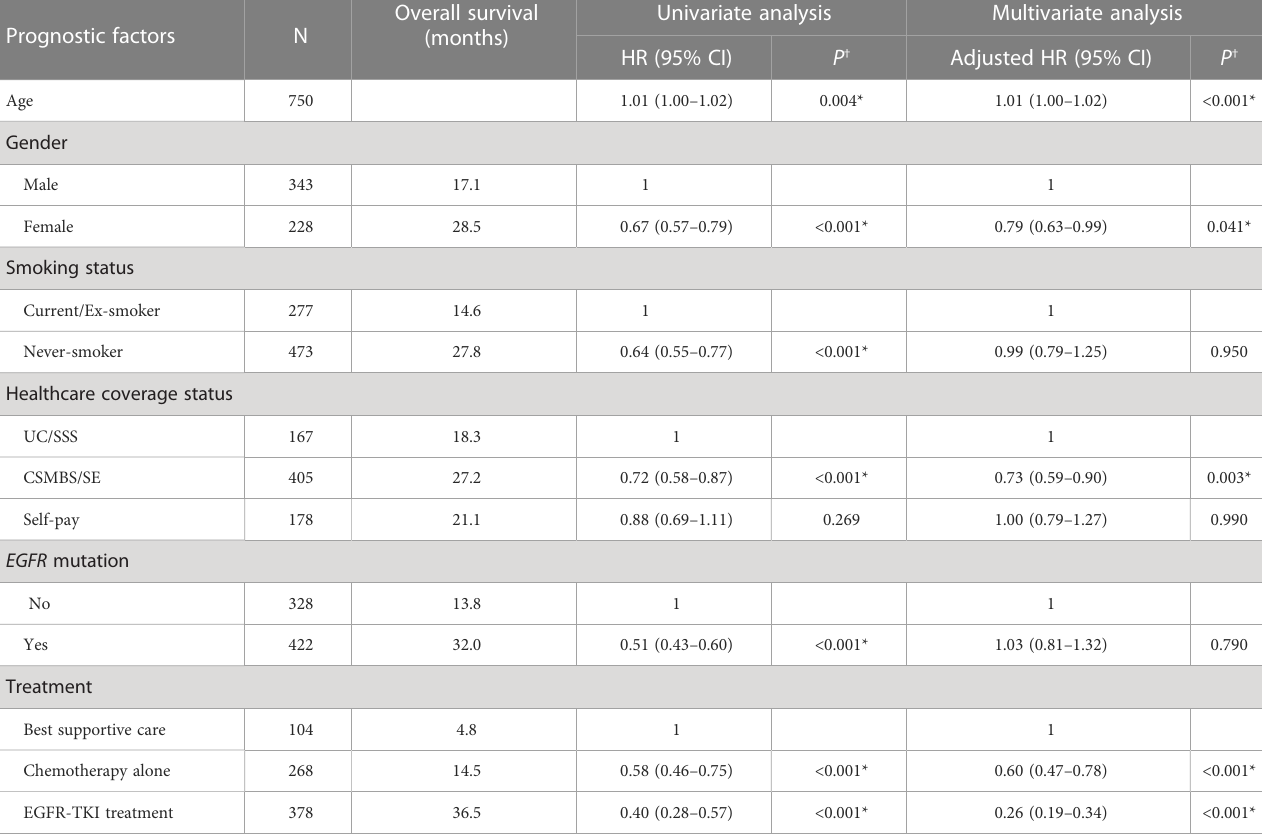
TABLE 2 Cox regression analysis of prognostic factors associated with overall survival of all patients.